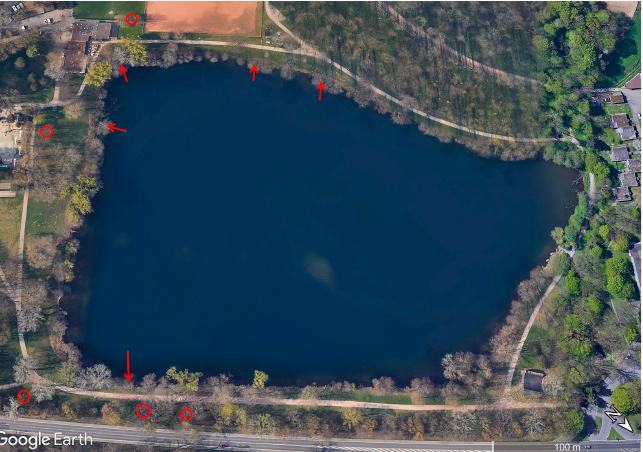
Figure 1. Map of sampling trees at the lake. Arrows and circles indicate the sample trees with sufficient and limited water resource, respectively.